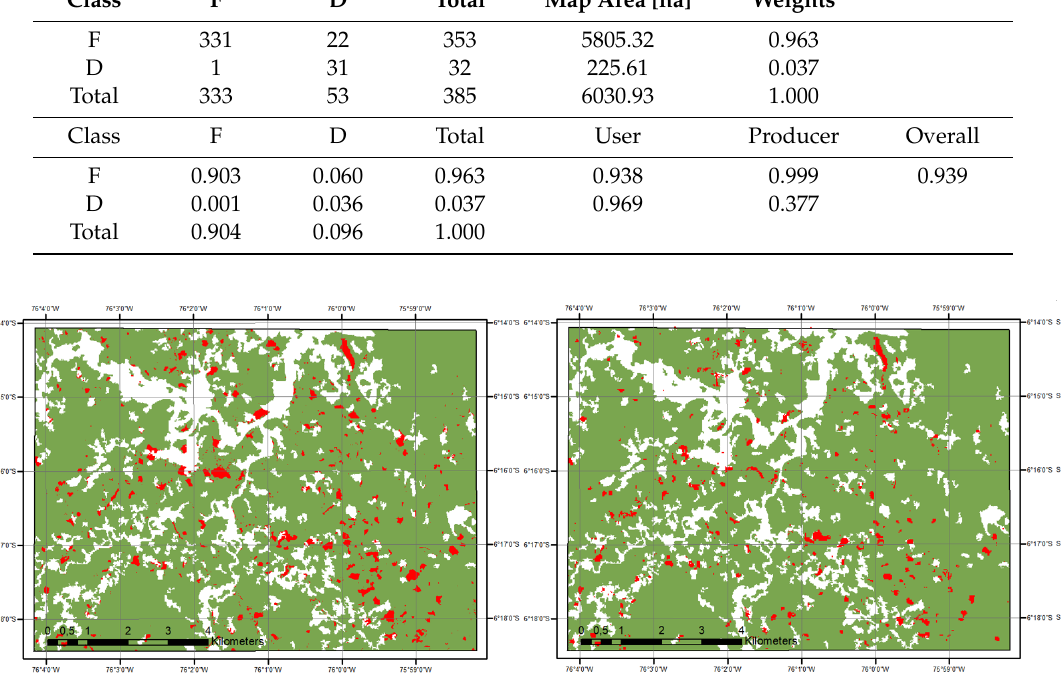
Figure 8. Comparison of S1 and optical “Union” disturbance detections ( left ) and Global Forest Watch disturbance detections ( right ) (March 2016-end of December 2016).